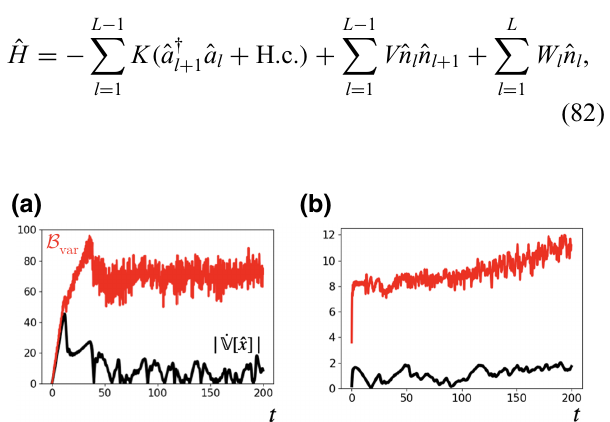
FIG. 7. The speed of the macroscopic coherence measured by ˙ V [ ˆ x ] | , and the speed limit B var in inequality the variance of ˆ x , | (55) for the initial states (a) | ψ 2 (cid:4) and (b) | ψ 3 (cid:4) for a single-particle system. The speed limit can provide a good bound, especially for t (cid:3) L /( 4 · 2 K ) from | ψ 2 (cid:4) [see (a)]. Moreover, it becomes smaller FIG. 8. An example of the graph E (or, equivalently, E X ) for when the expectation value of the transition Hamiltonian (rela- the system with many hardcore bosons in Eq. (82). We can cal- tive to R p ) becomes larger [see (b)]. We use K = 1, W l = 0, L = culate X i for each Fock state | i (cid:4) . We have (cid:8)∇ X (cid:8) ∞ = 1 and 100, and M = 1. C H = 2 MK . The case with L = 6 and M = 2 is